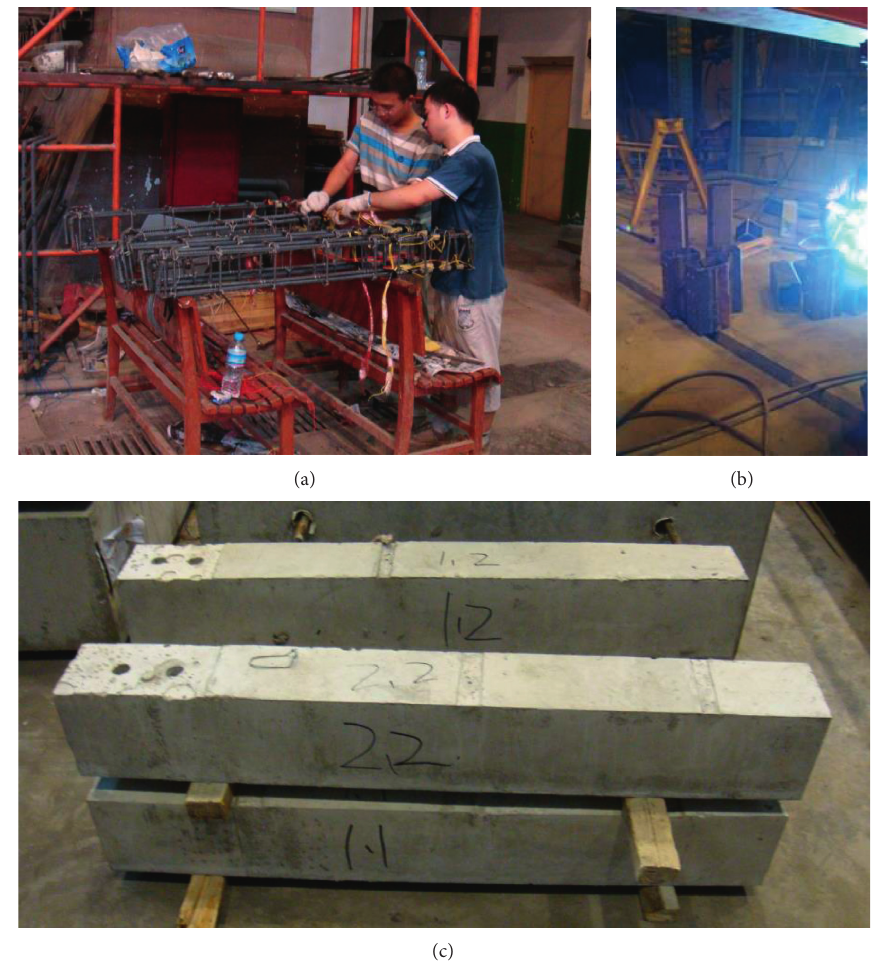
Figure 3: Specimen preparation. (a) Reinforcement skeleton of beam, (b) steel plate hoop, and (c) precast concrete components.